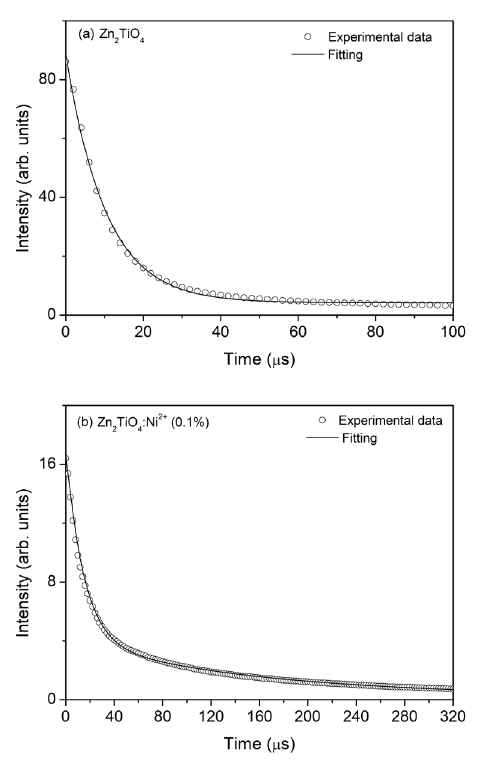
Figure 10. Photoluminescence decay time at room temperature excited with 360 nm and monitored at 718 nm of (a) Zn (b) Zn TiO :Ni 2+ (0.1% of Ni 2+ 2 4